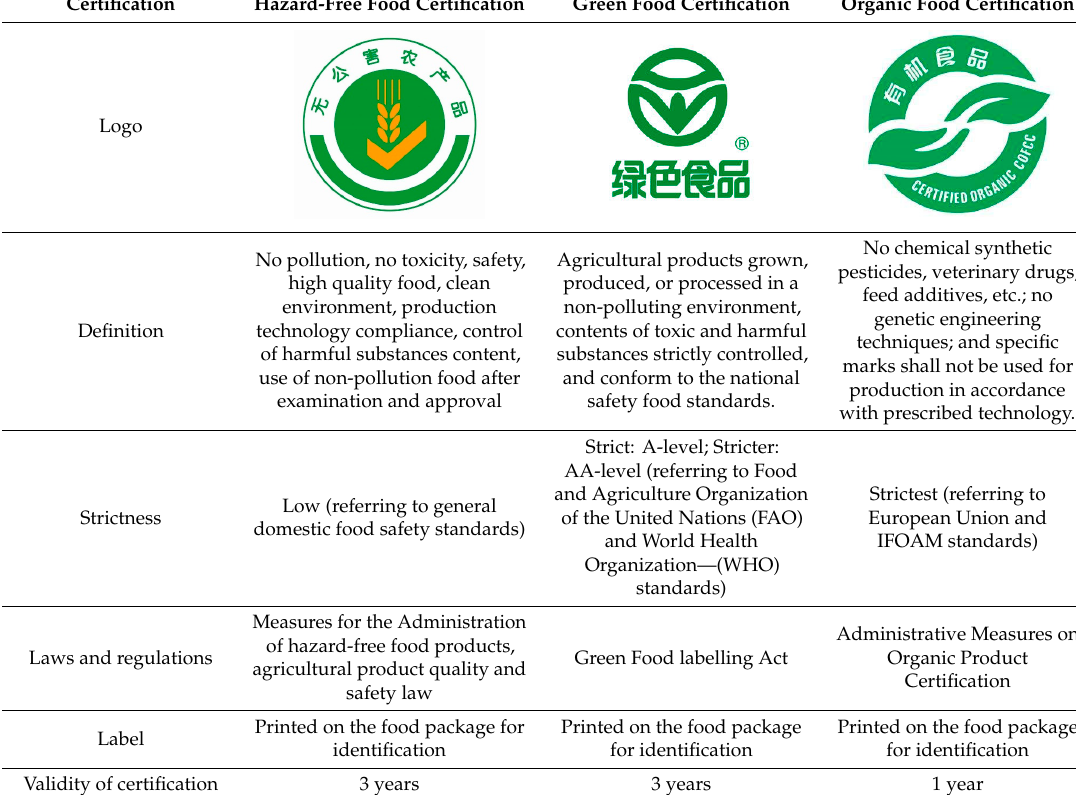
Table 1. Comparison of hazard-free food, green food, and organic food certifications.